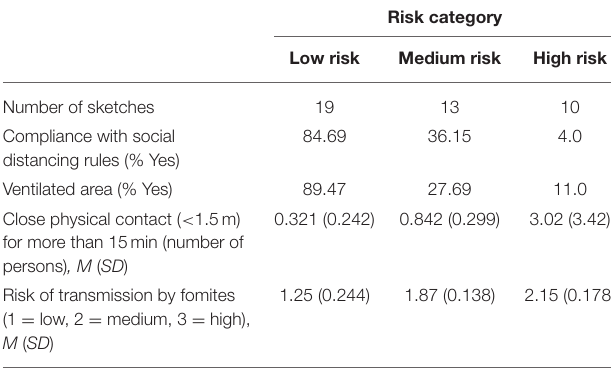
TABLE 1 | Characteristics of the situations belonging to the three risk